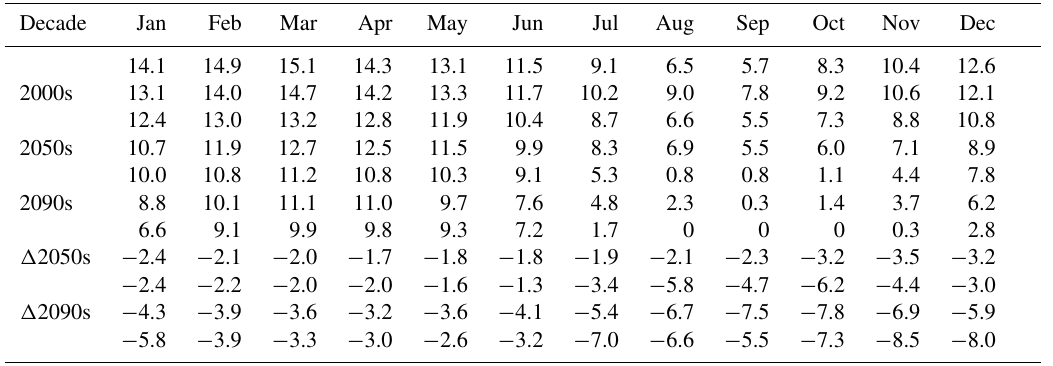
Table 1. Decadal mean Arctic sea ice extent monthly averages for 2000s, 2050s and 2090s and changes for the two latter decades compared to the former, following the RCP8.5 scenario. 2000s: first number within row from NSIDC; second number within row from NorESM; third number within row from CCSM. Other decades: first number within each row from NorESM; second number within each row from CCSM. Unit is 10 6 km 2